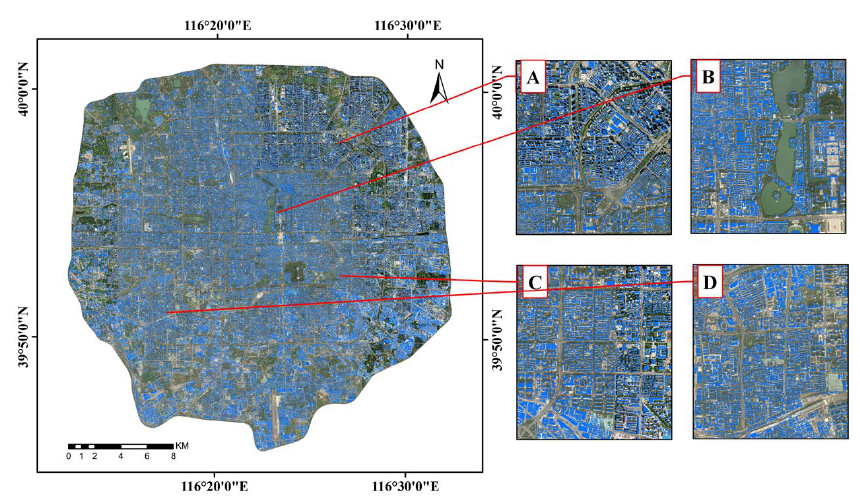
Figure 2. Building data overlaid with satellite images. (( A – D ) are the four sample regions for display.)